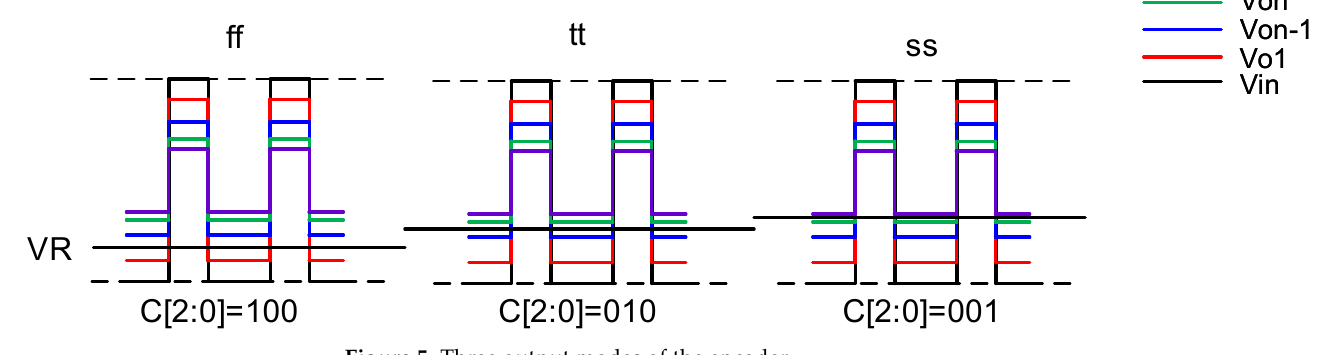
Figure 5. Three output modes of the encoder. Table 1. Temperature coding under different process corners.